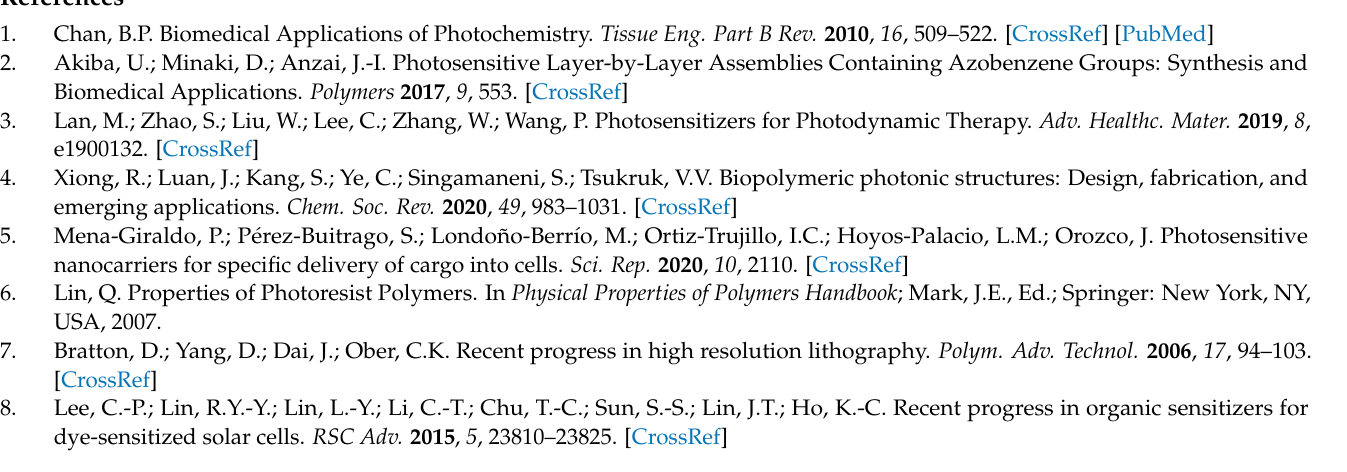
Figure S2: Fluorescence of chitosan derivatives under 365 nm light: CS-BIm (a), CS-BOx (b), and CS-BTh (c); Figure S3: UV-Vis spectra of unmodified chitosan (2% solution in acetic acid) exposed to UV-C radiation in time up to 120 min; the arrow shows the direction of absorbance changes; Figure S4: Changes in FTIR spectra (offset) of studied films during 0–8 h UV-irradiation: CS-BIm (a), CS-BOx (b) and CS-BTh (c). The spectrum at the top corresponds to the unexposed sample, at the bottom after 8 h